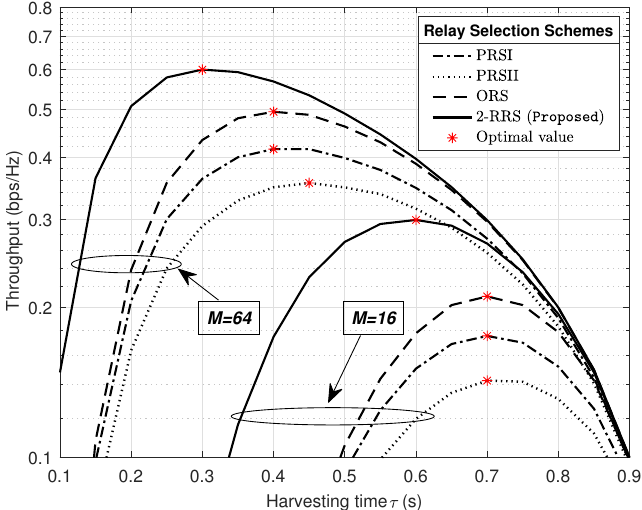
Figure 9. The impact of harvesting time allocation τ in the throughput system performance for different relay selection schemes with P PB = 10dB and M = { 16, 64 }